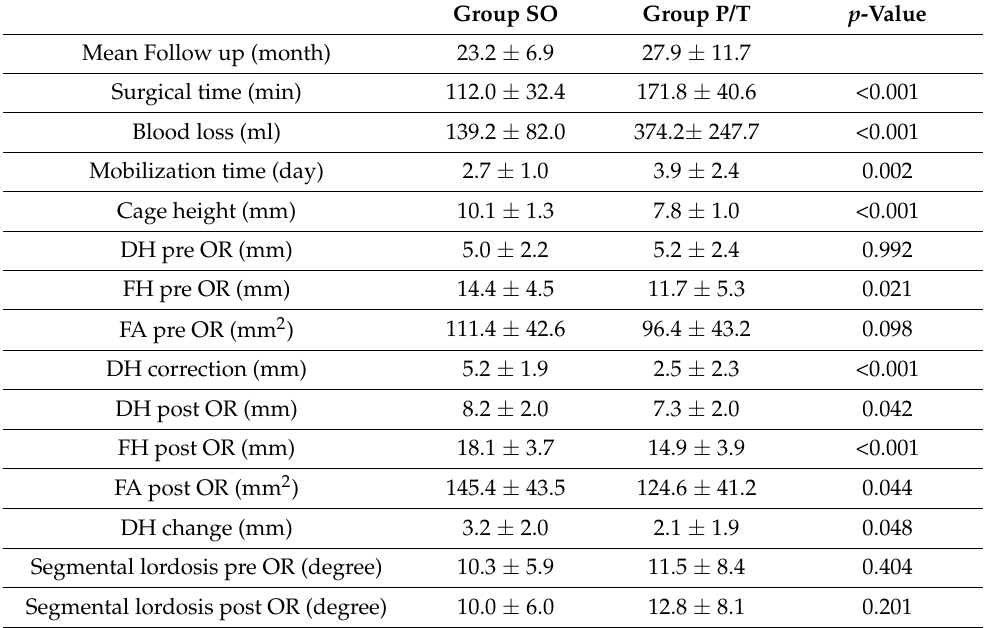
Table 2. Surgical and radiographic results for Group SO and Group